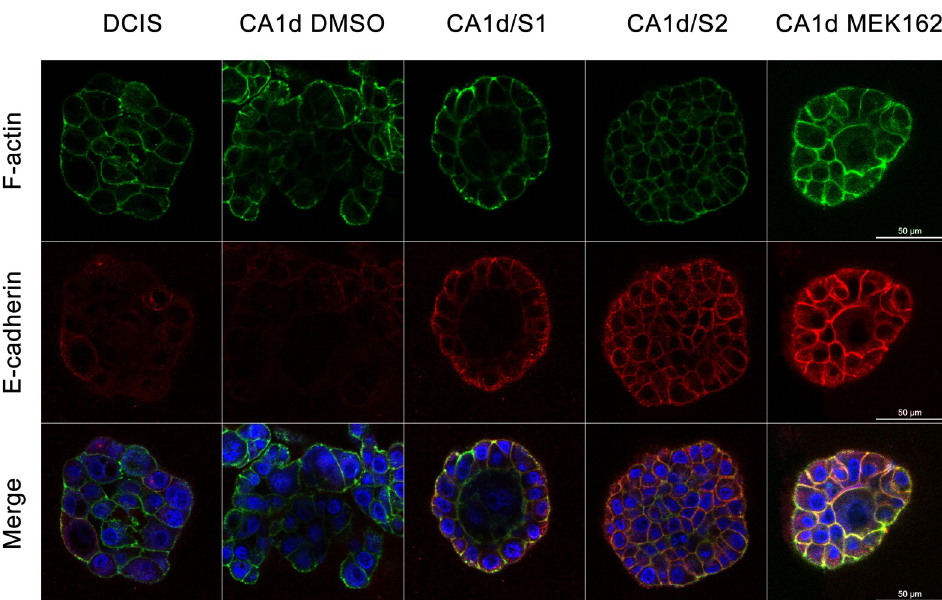
Fig 6. Sprouty4 overexpression supports the restoration of E-cadherin. MCF10.DCIS, as well as MCF10.CA1d control and Sprouty4 overexpressing cell lines (CA1d/S1 and CA1d/S2) were grown in 3D rBM overlay cultures for eight days. During the last 48 hours, CA1d cells were treated with either DMSO or 100 nM MEK162. Confocal fluorescent imaging was performed using a 63x objective. Equatorial planes of 3D reconstructions show phalloidin- FITC for filamentous actin (green), indirect immunofluorescence for E-cadherin (red), and DAPI for nuclei (blue); size bar = 50 μ m. The localization of E-cadherin staining in the Sprouty4 overexpressing and MEK inhibited cells is consistent with relocation to the cell surface and the restoration of adherens junctions. Images are representative of three independent experiments.